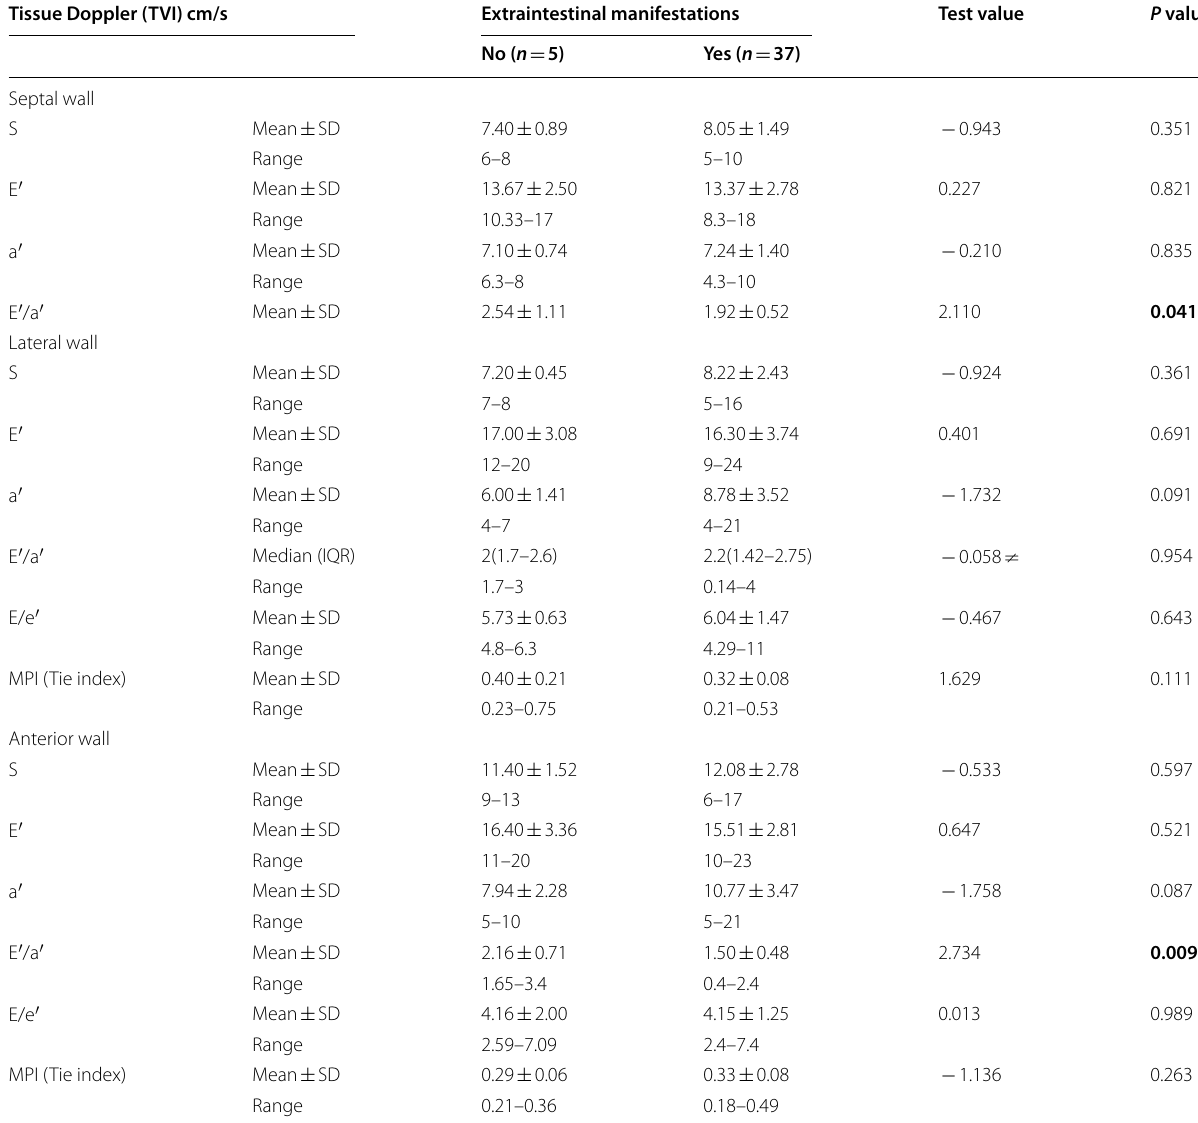
Table 5 Relation between the presence of extraintestinal manifestations and tissue Doppler results in Celiac patients Tissue Doppler (TVI)